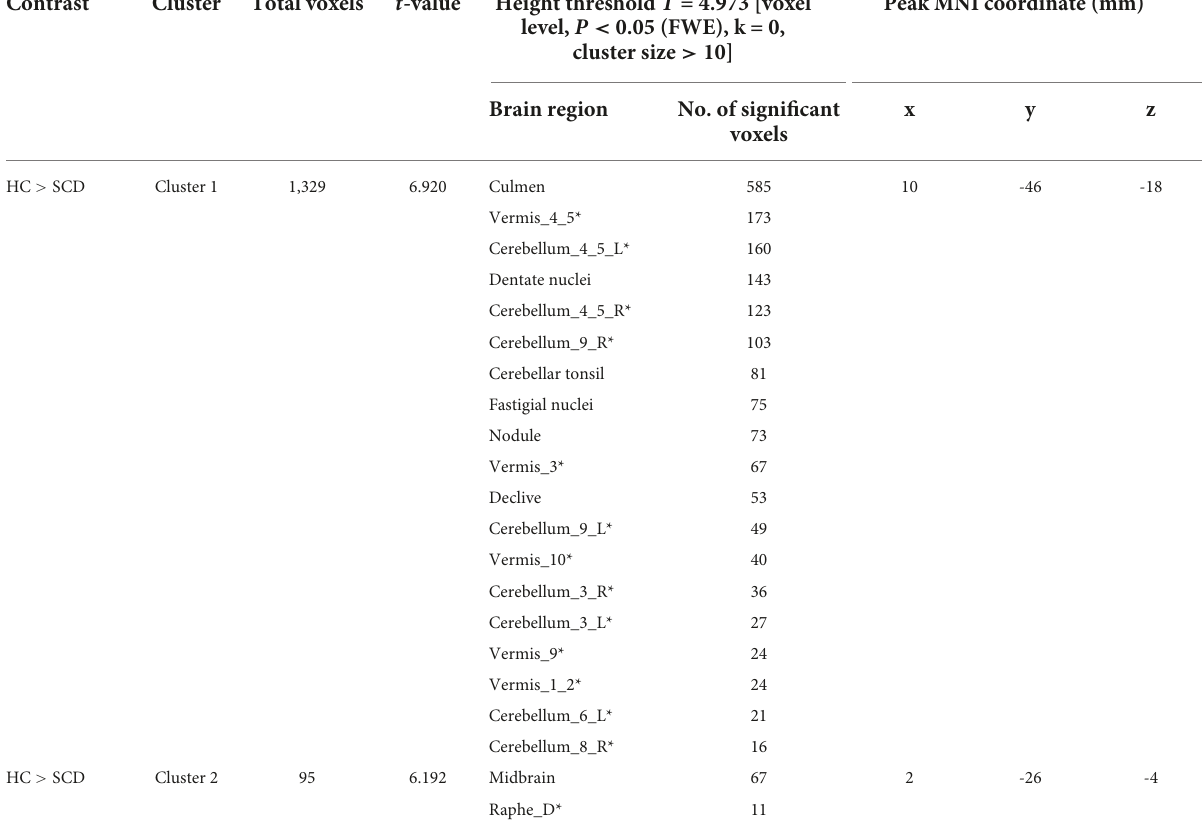
*BrainlabelsdefinedinAAL3.TheArabicnumeralsintheAAL3brainlabelsindicatedthelobulenumberofthecerebellarhemisphereorvermis.Forexample,theanatomicaldescription forCerebellum_4_5_LwasthelobuleIV,Voftheleftcerebellarhemisphere.